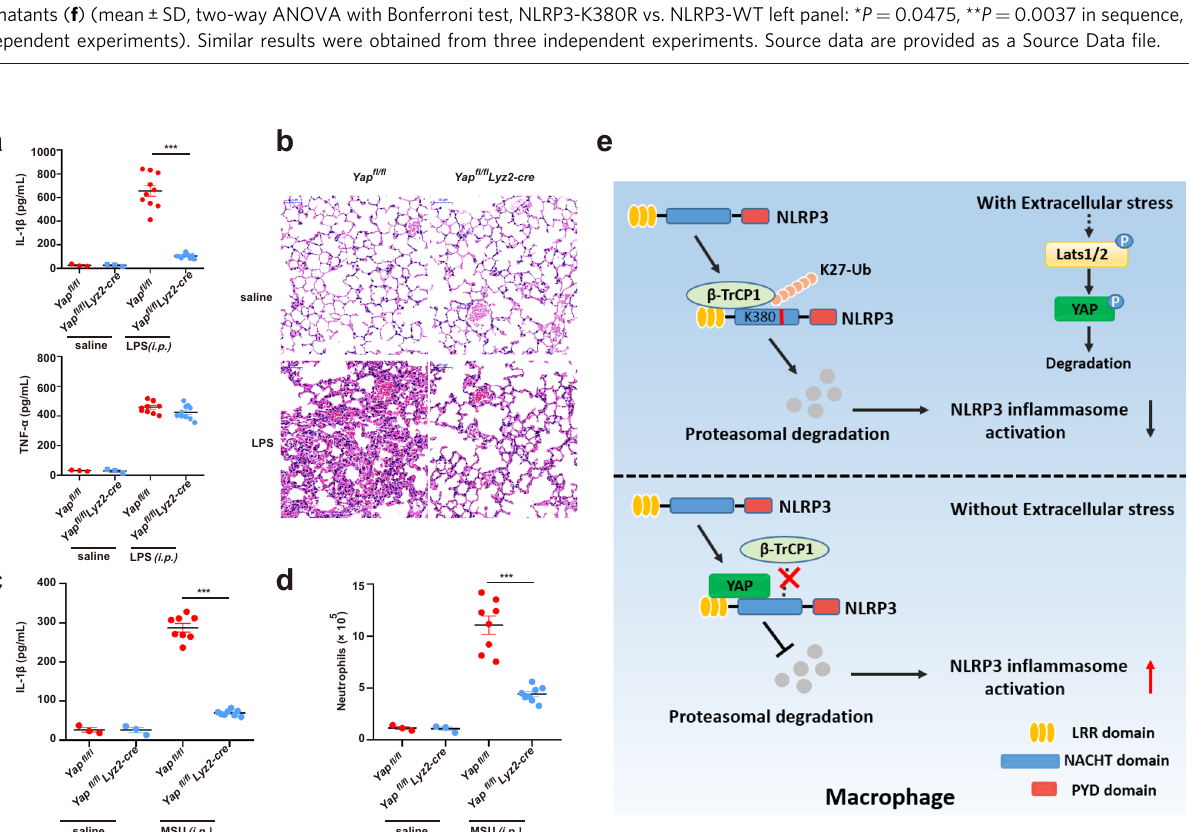
Fig. 7 Lys380 in NLRP3 is essential for its ubiquitination and degradation. a Immunoblot analysis of lysates from HEK293T cells transfected with HA- tagged K27-linked ubiquitin (K27-Ub), β -TrCP1 and Myc-NLRP3 or indicated mutant Myc-NLRP3, followed by IP with anti-Myc, probed with anti-HA. b Immunoblot analysis of lysates from HEK293T cells transfected with Myc-NLRP3, Myc-NLRP3 K380R, and then treated for various times with cycloheximide (CHX, 100 ug/mL) (top). NLRP3 and NLRP3 K380R expression levels were quantitated by measuring band intensities using “ ImageJ ” software. The values were normalized to actin (bottom) (mean ± SD, two-way ANOVA with Bonferroni test, NLRP3-K380R vs. NLRP3-WT lower panel: * P = 0.0129, * P = 0.0321, ** P = 0.0010 in sequence; n = 3 independent experiments). c Immunoblot analysis of lysates from HEK293T cells transfected with Flag- β -TrCP1 and Myc-NLRP3 or Myc-NLRP3 K380R. d ELISA of IL-1 β in supernatants from HEK293T cells transfected with ASC, pro-caspase-1, pro- IL-1 β , NLRP3 or NLRP3 K380R plasmids and stimulated with 10 μ M nigericin (mean ± SD, one-way ANOVA with Bonferroni test, the third group vs. second